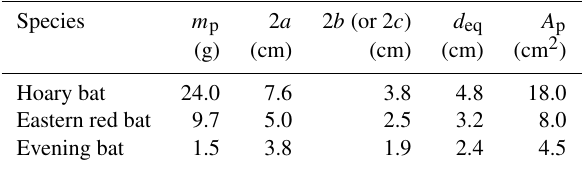
Table 1. Physical properties of freshly discovered bat